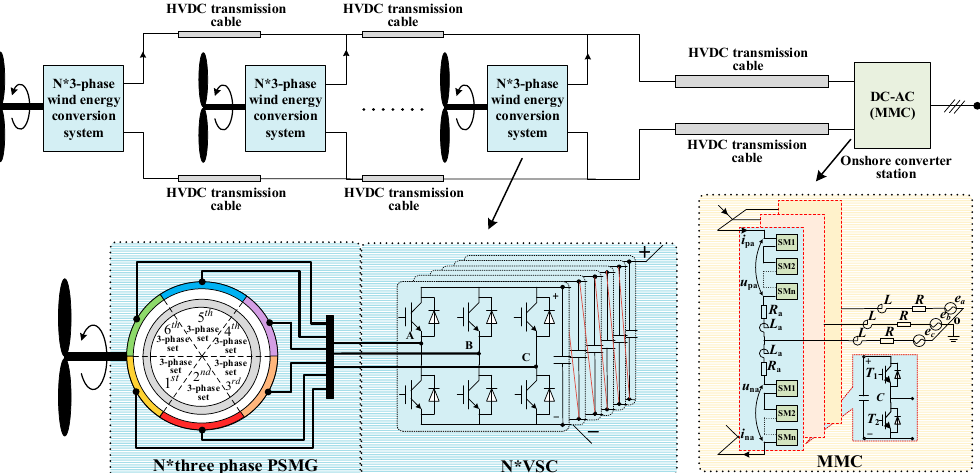
Figure 1. The topology of the proposed wind power generation system with N* three-phase PSMG based on HVDC.